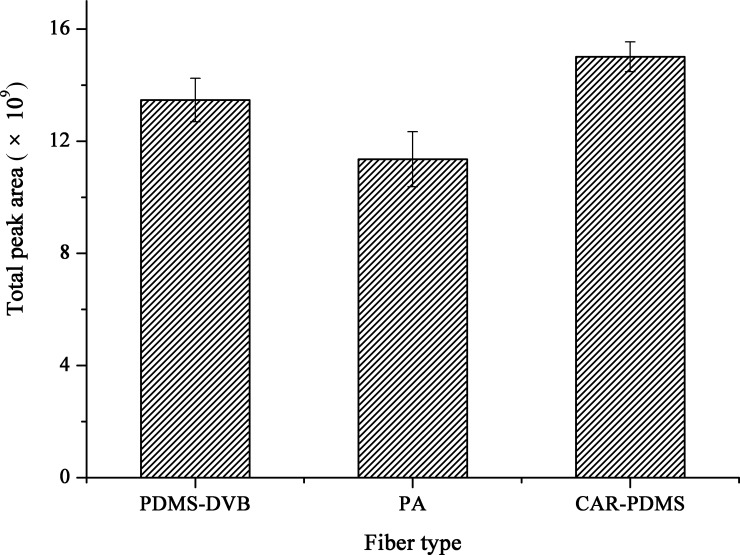
The total peak areas and peak number obtained by different fiber coatings.